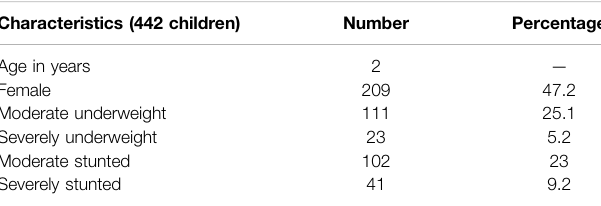
TABLE 1 | Clinical and demographic features of children in Mirpur slum area, Dhaka, Bangladesh. Moderate underweight − 3 ≤ WAZ < − 2, severely underweight WAZ < −